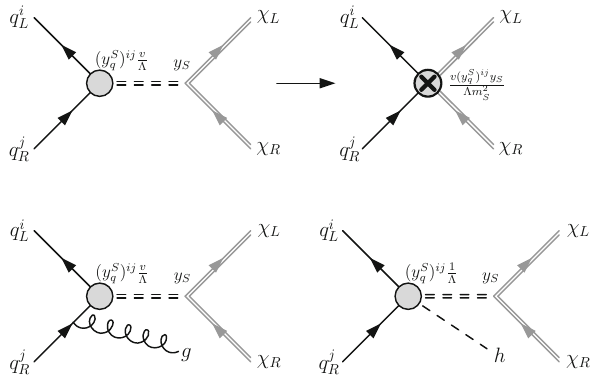
Fig. 1 Relevant diagrams contributing to nuclear interaction with fermionic DM (first row) and corresponding DM observables at hadron colliders (monojet and Higgs + / E T , second row), turning on the inter- actions ∼ ( y S q ) ij and ∼ y S . The diagrams are similar for scalar and pseudo-scalar mediators, where for the latter case, the operator coeffi- cients in Eq. (1) are to be replaced by the corresponding (tilded) coef- ficients in Eq. (3). See text for